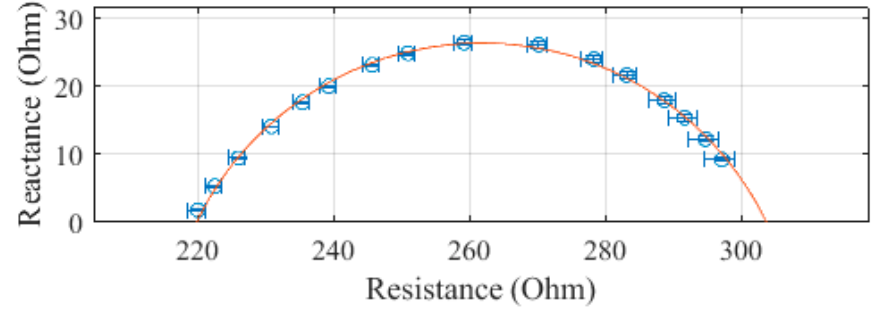
Figure 15. Cole–Cole plot of the leg impedance of subject 1 measured with a Seca 514.